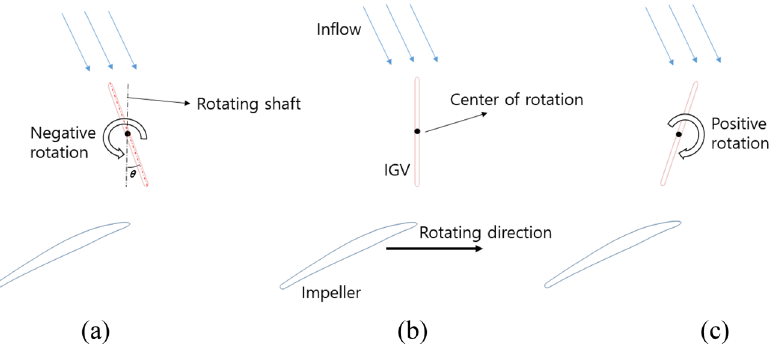
Figure 2. Schematic of the IGV’s setting angle. ( a ) Negative angle, ( b ) reference, and ( c ) positive